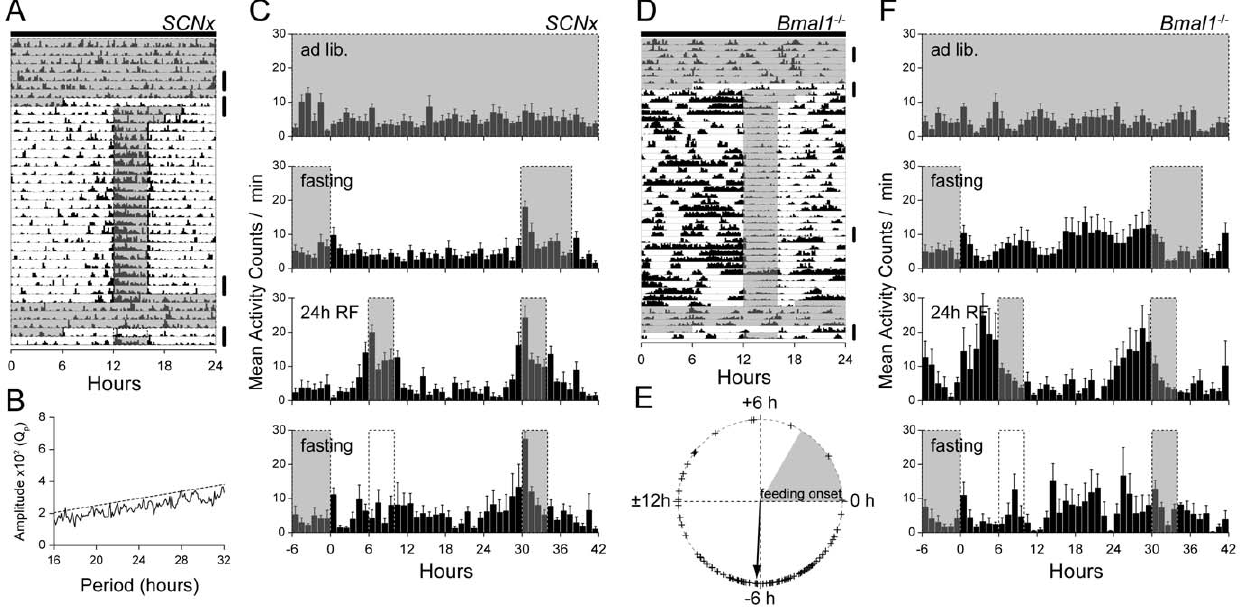
Figure 3. Persistence of FAA rhythms during food deprivation in the case of entrainment. ( A ) Representative actogram of locomotor activity in SCN-ablated C57BL/6 wild-type mice under 24 h RF schedule. Time is plotted left-to-right in 10-min bins. Mice were maintained in constant darkness as indicated by closed bars at the top of the actograms. Feeding time is indicated by gray shaded boxes. ( B ) Periodogram during the baseline before RF from the mouse represented in ( A ). ( C ) Group profiles of locomotor activity are plotted for 48 h in a 60-min bin (n=6). Serial- plotted portions are indicated by a thick vertical line in ( A ). Previous feeding time is indicated by transparent dotted boxes. ( D ) Representative actogram of locomotor activity in Bmal1 2 / 2 mice under 24 h RF schedule. ( E ) Circular analysis of inter-day deviation of the pre-feeding activity phase in individual Bmal1 2 / 2 mice. The start of feeding time is set to zero. The mean pre-feeding activity phase to 24-h RF schedule is indicated by a thick arrow (n=5). ( F ) Mean profiles of locomotor activity are plotted for 48 h in a 60-min bin (n=6). Serial-plotted portions are indicated by a thick vertical line in ( D ).